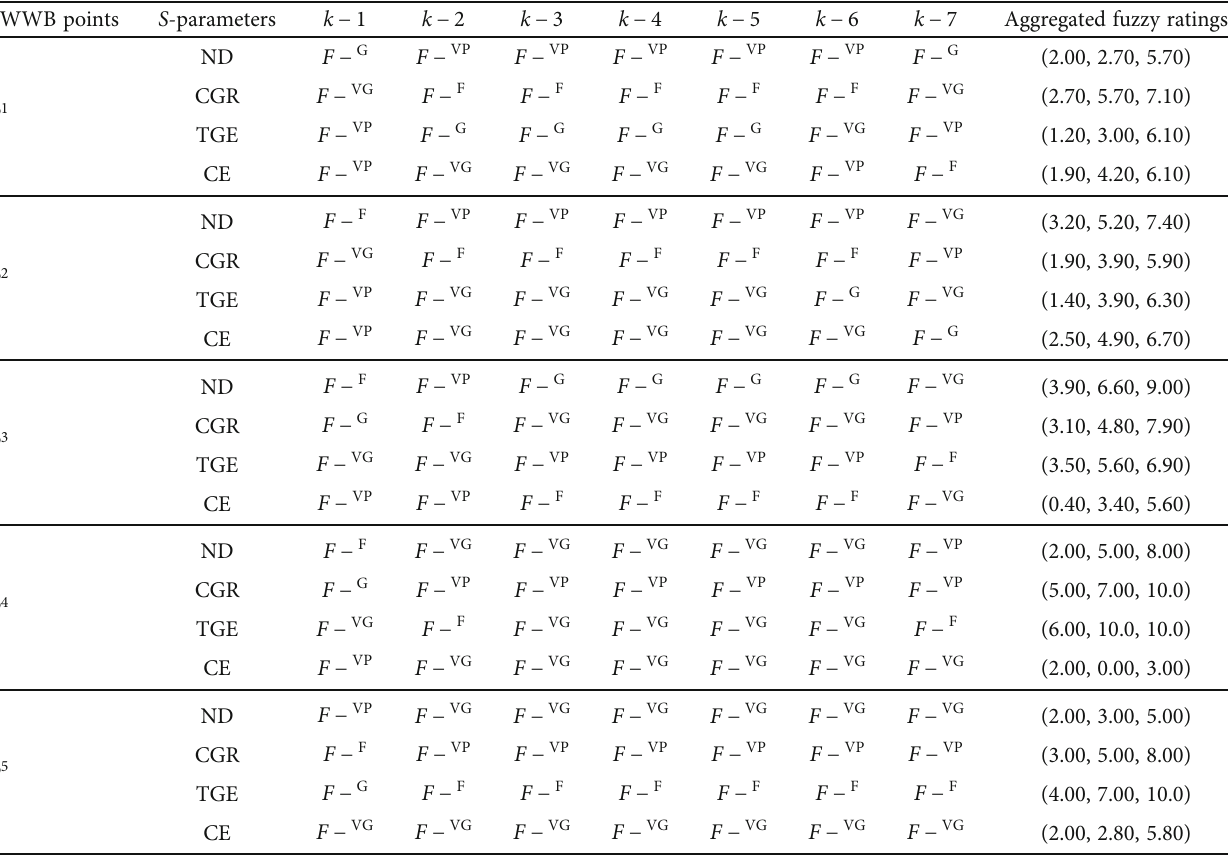
Table 4: Fuzzy ratings and aggregated fuzzy ratings vs. FWWB S